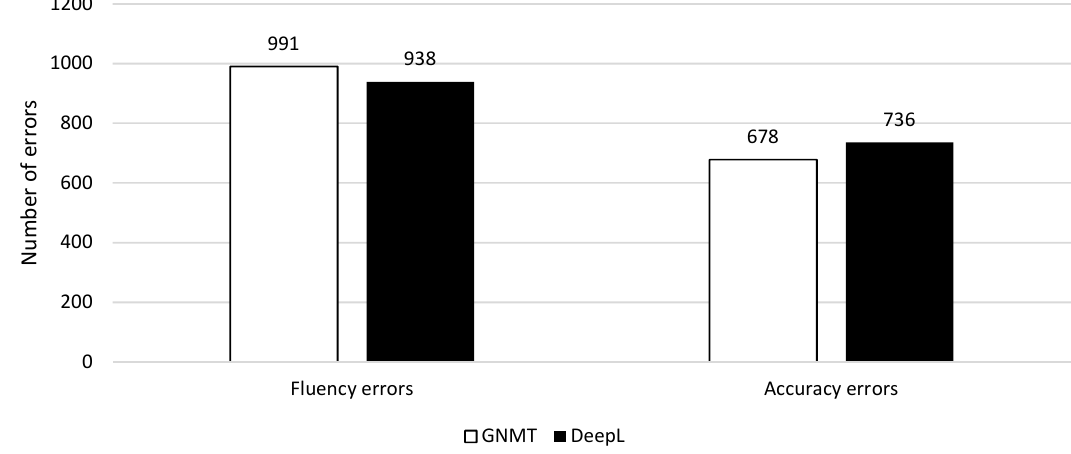
Figure 6. Distribution of fluency and accuracy errors per NMT system for all four